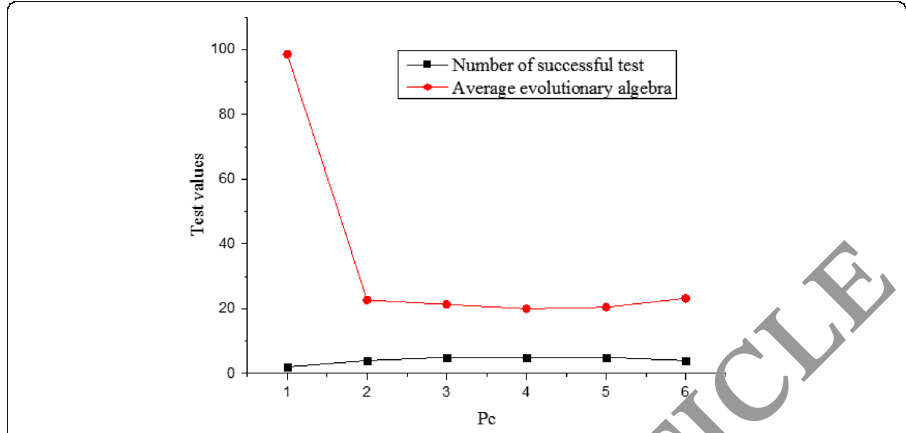
Fig. 5 Influence of parameter crossover probability on algorithm convergence